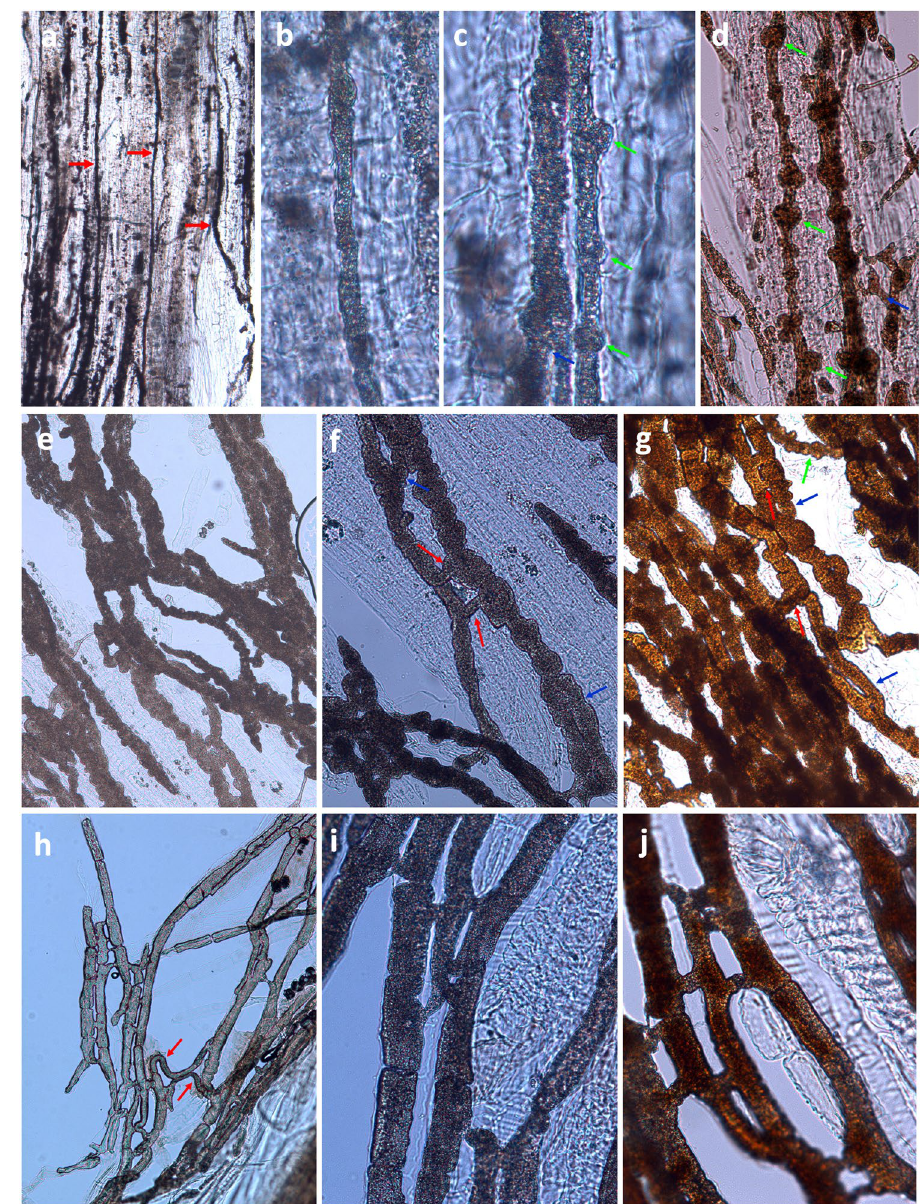
stained with iodine and bromine solution ( j ). Yellow arrows indicate primary laticifers; green arrows indicate intrusive growth by “budding;” blue arrows indicate laticifer branches; red arrows indicate linkage tubes between two